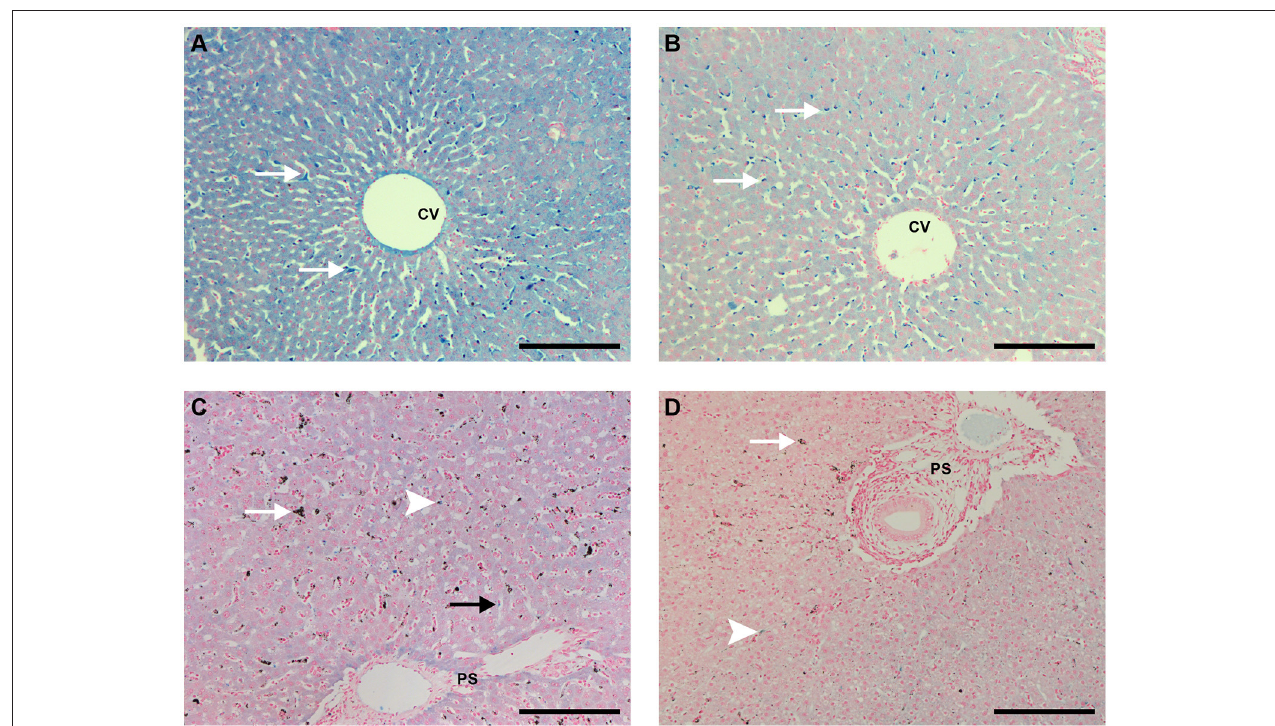
FIGURE 9 | Liver sections Perls staining (bar: 200 µ m). (A) Liver of an uninfected, control animal that received PBS (code PA11), showing blue staining throughout the hepatocytes, with stronger staining in Kupffer cells (arrows); CV: centrilobular vein (B) Liver of an uninfected Saimiri inoculated with CL 1 mL (code V3). The blue stainingwas lighter, especially in hepatocytes, with Kupffer cells still showing more pronounced staining (arrows). CV, centrilobular vein. (C) Liver of a P. falciparum -infected Saimiri that received PBS (code 216: treated at day 17, with 1,3% parasitemia, killed 5 days later). Iron staining was lighter than (A) in both hepatocytes and Kupffer cells, but still visible; Kupffer cells were laden with hemozoin (arrow); in only sporadic cases colocalization of hemozoin and iron staining was observed in Kupffer cells (arrowhead). PS: portal space. (D) Liver of a P. falciparum -infected Saimiri that received CL 1 mL (code 161: treated at day 11, with 22% parasitemia, killed 5 days later). Both iron staining (arrowhead) and hemozoin (arrow) were decreased in relation to (C) . PS: portal